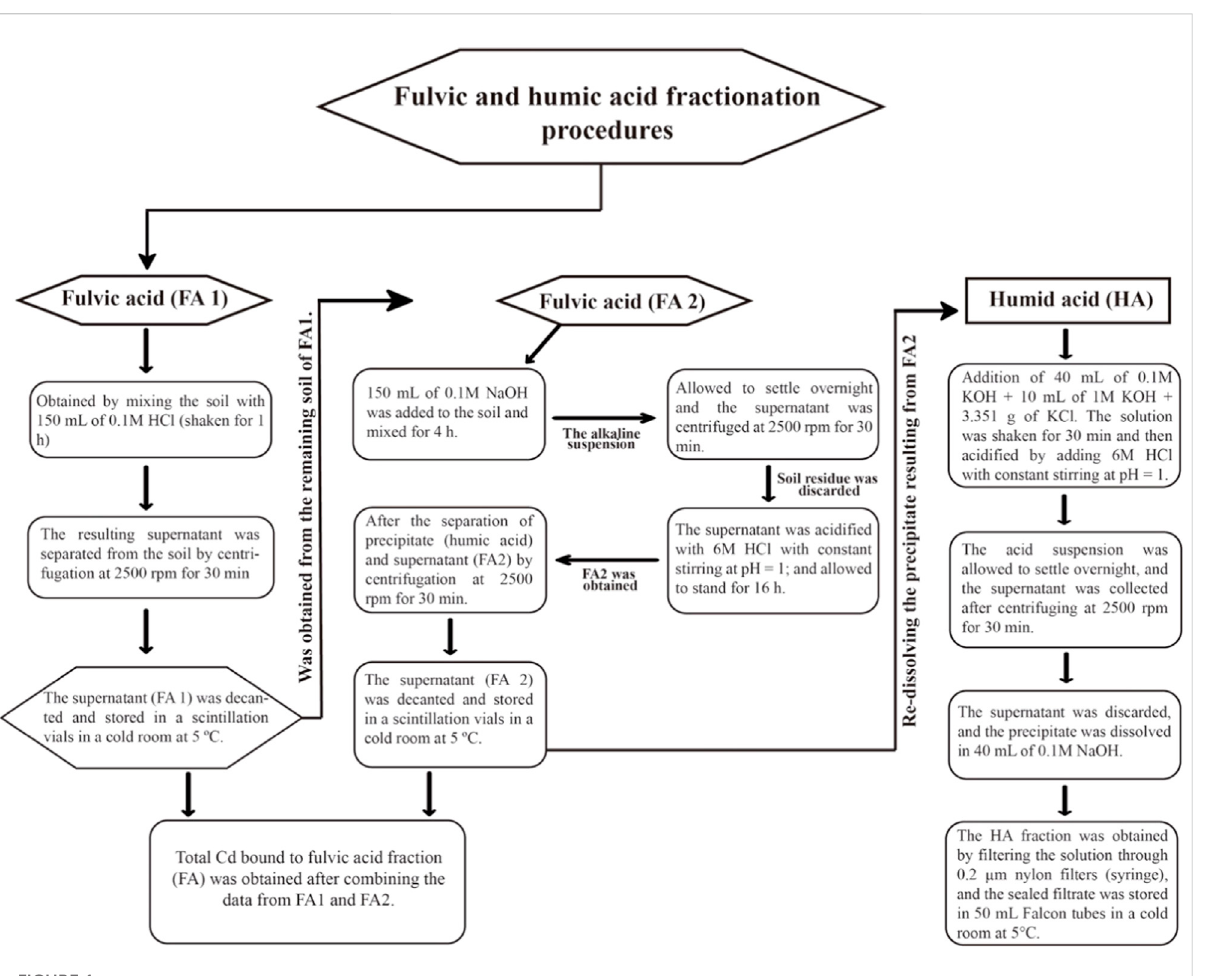
FIGURE 1 Flow chart for Fulvic (FA) and Humic acid (HA)